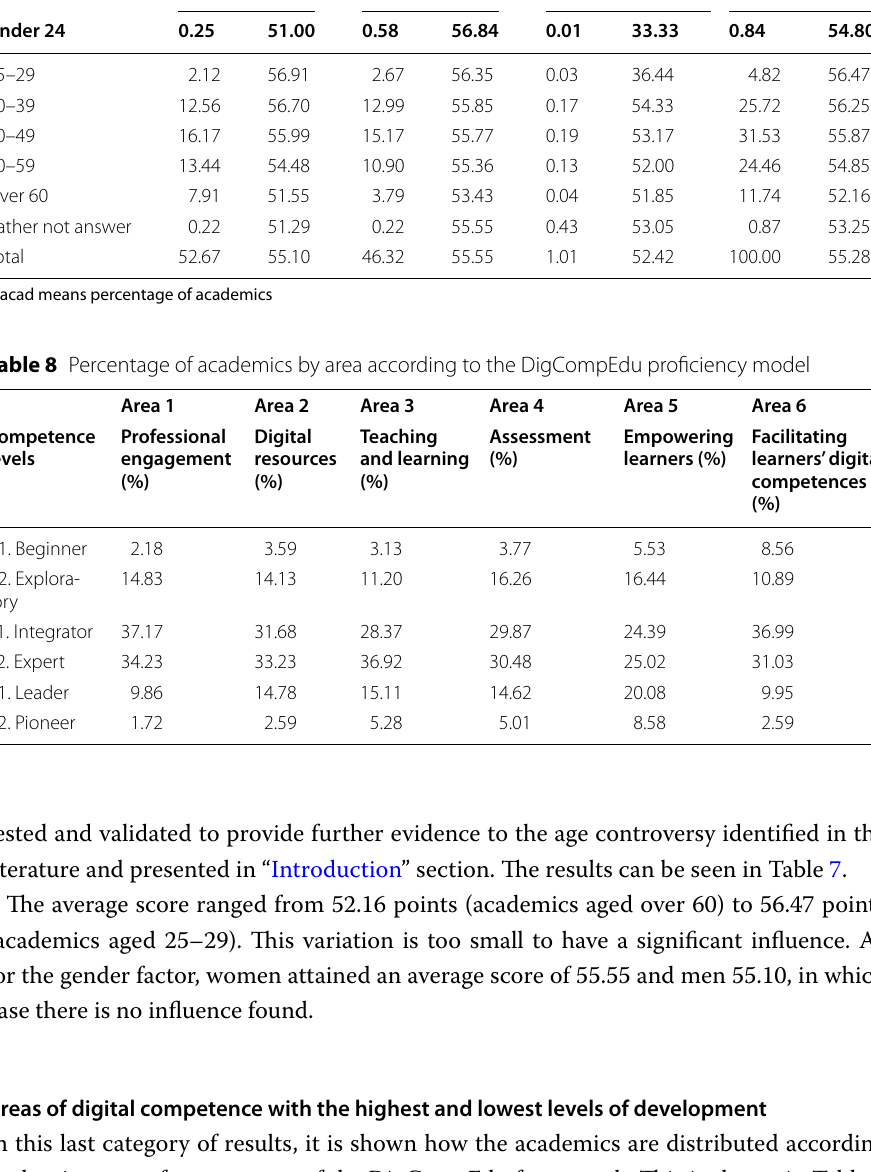
No answer & others %acadScore